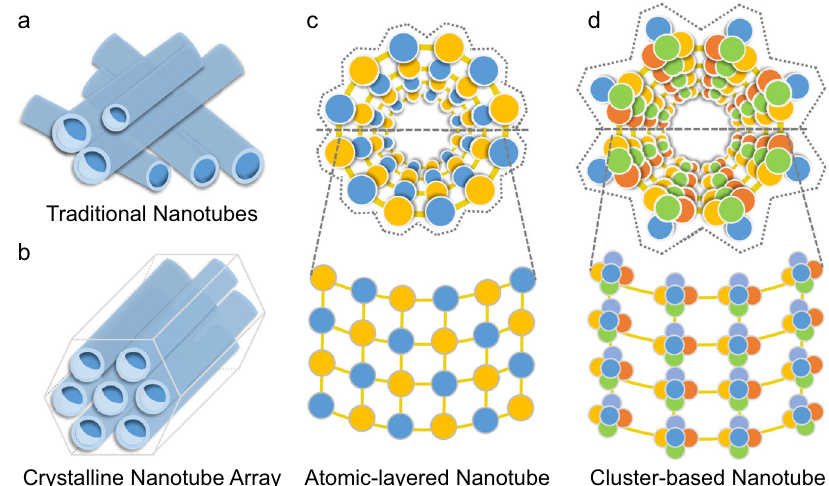
Fig. 1 Two known types of nanotubes. Comparisons of ( a ) traditional nanotubes and ( b ) a crystalline nanotube array. Comparison of ( c ) an atomic-layered nanotube and ( d ) a cluster-based